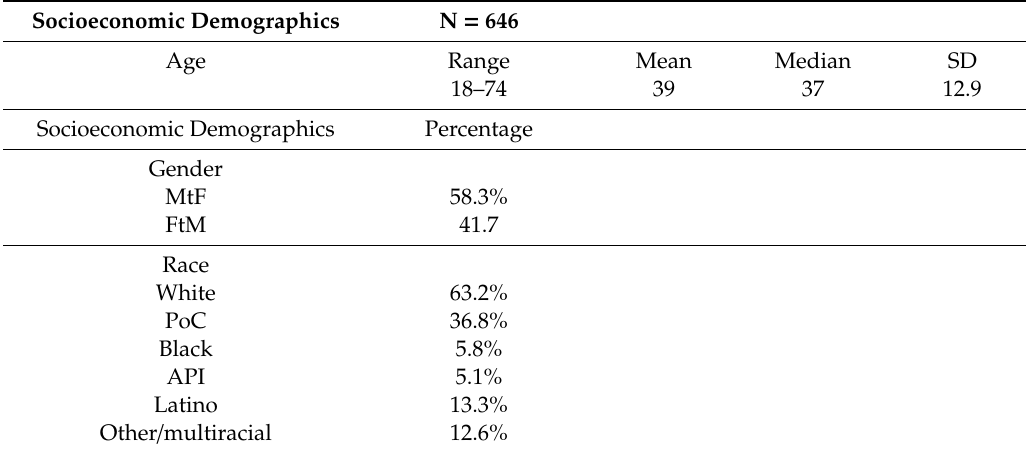
Table 2. Socioeconomic